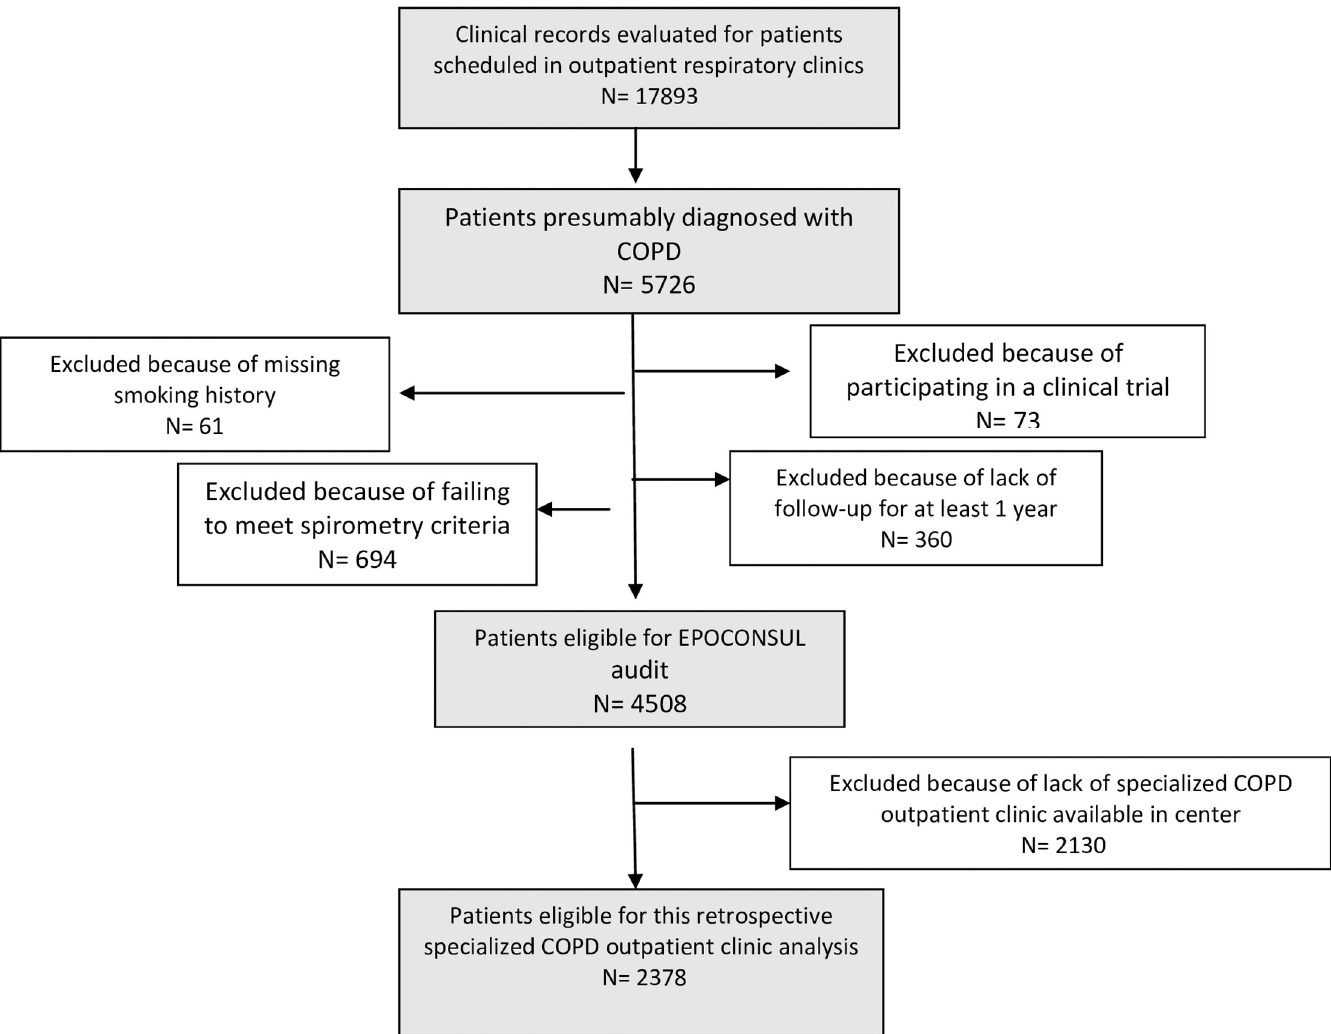
Fig 1. The sampling process described in a STROBE flow chart. A total of 4508 clinical records of patients treated in outpatient respiratory clinics from 59 hospitals were audited. Of this cohort, only 2378 patients audited from 28 hospitals with available outpatient clinic settings (general versus specialized COPD) were included in the